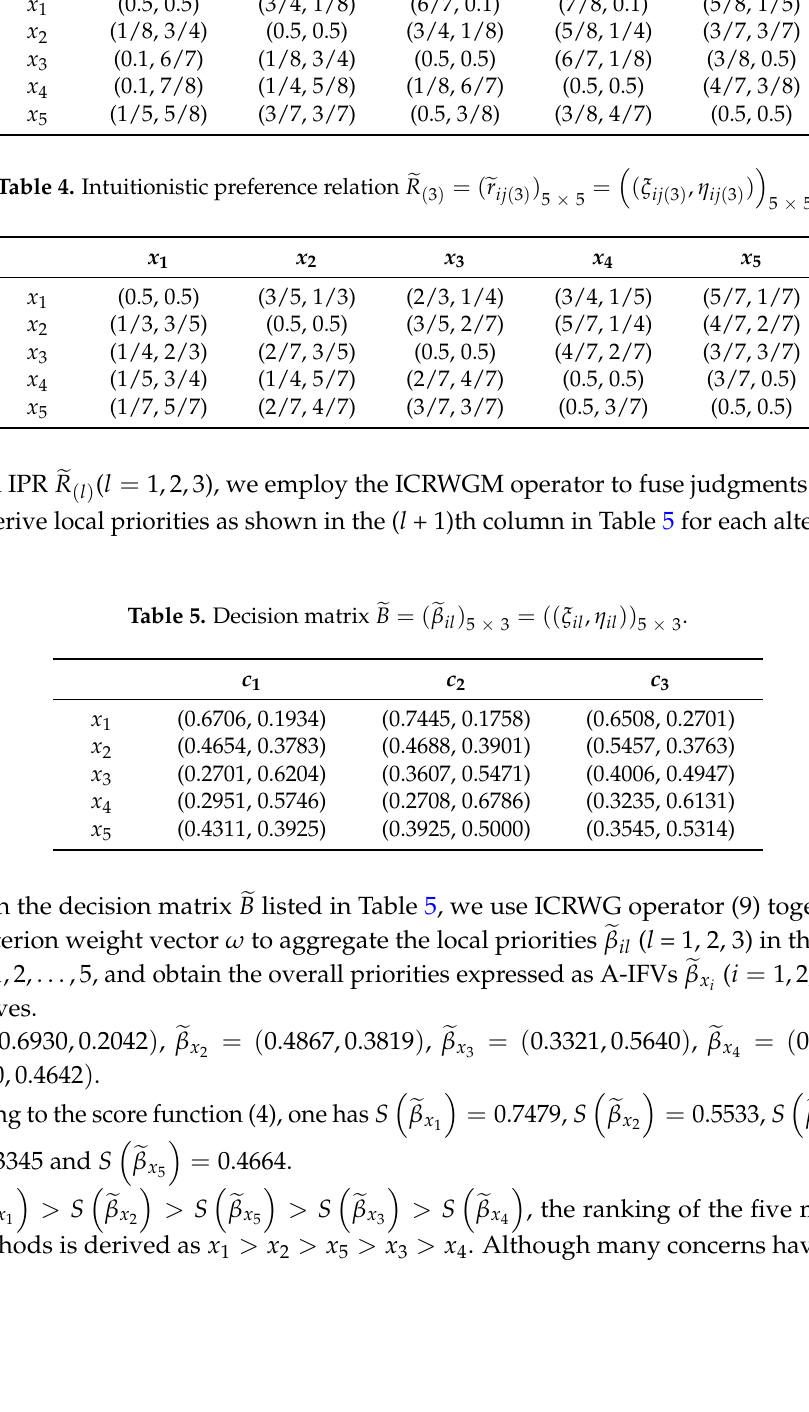
(cid:16) = ( ξ ij ( 2 ) , η ij ( 2 ) 5 × 5